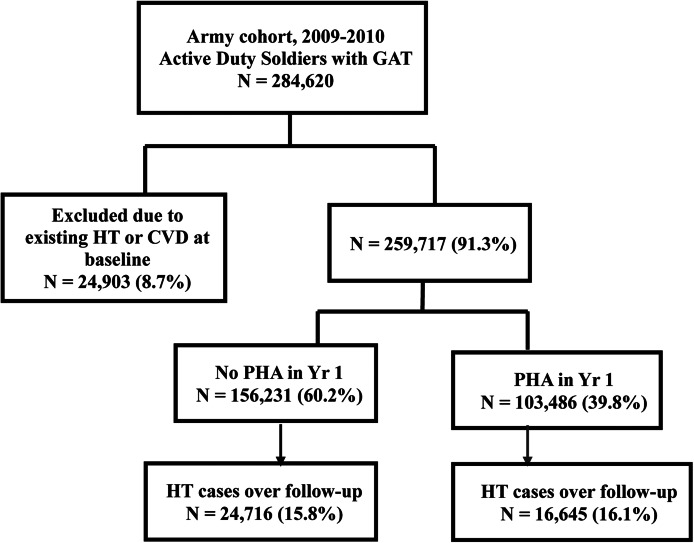
Study population flow chart. Diagram showing how we derived the analytic sample. Soldiers missing a PHA may have completed their physical sometime leading up to or shortly after the specified 12-month baseline window. The PHA includes measures of family history of CVD, diabetes status, BMI, smoking, alcohol misuse, SBP and DBP. GAT: global assessment tool; HT: hypertension; CVD: cardiovascular disease.